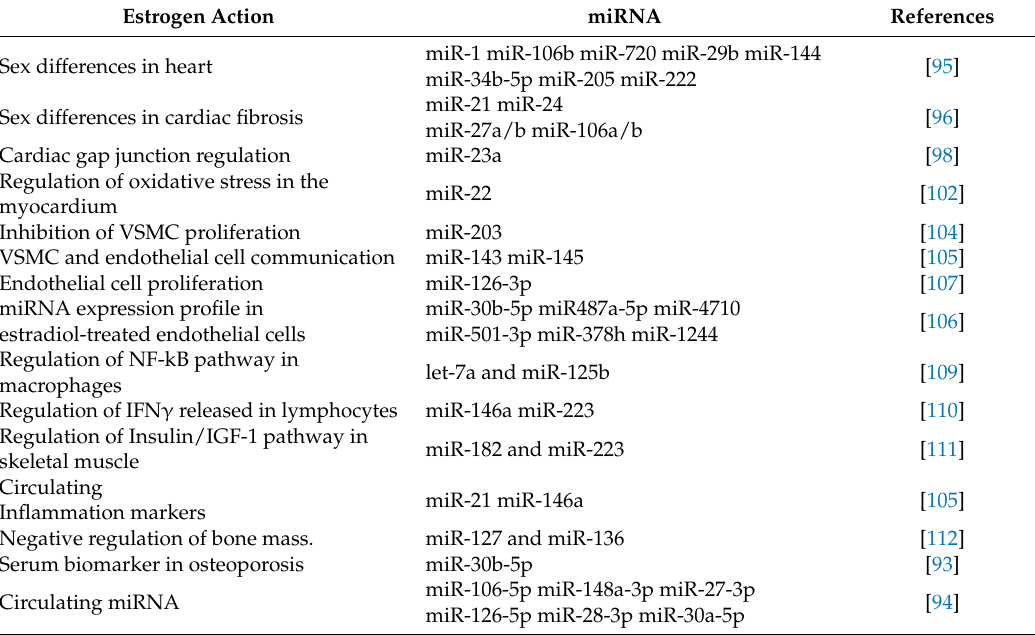
Table 2. miRNA-dependent estrogen actions. Focusing on the role of estrogen in cardiovascular system and in HRT, estrogen-dependent effect and its associated estrogen-related miRNA are